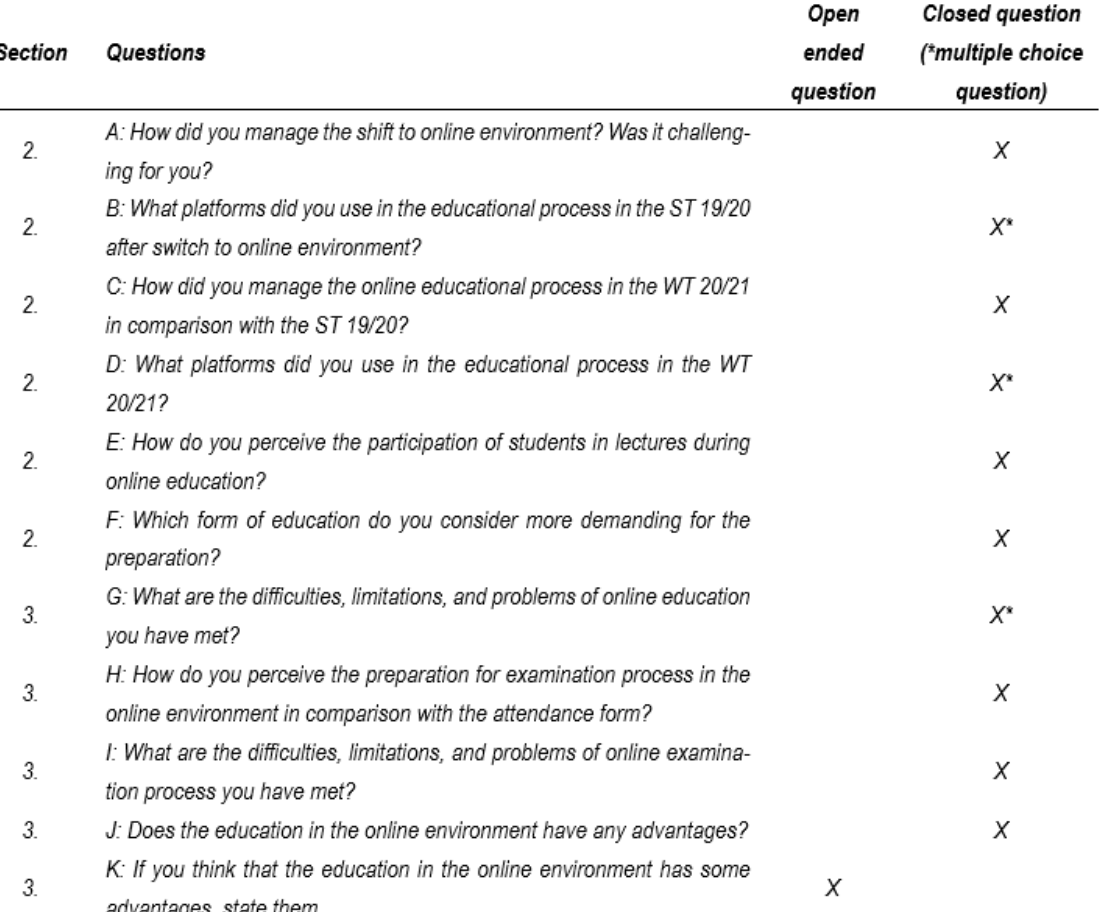
Questions in the Second and Third Section in the Teachers’